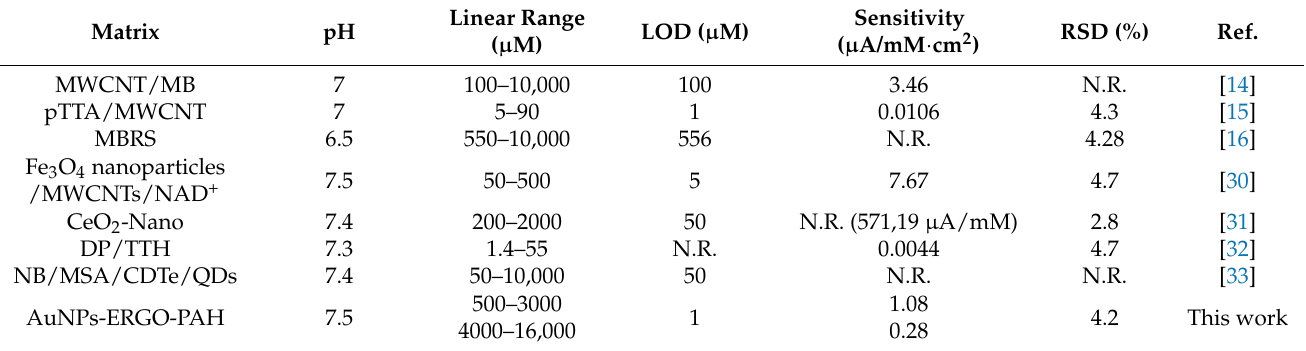
Linear Range Sensitivity LOD ( µ M) RSD (%) ( µ M) ( µ A/mM · cm 2 )